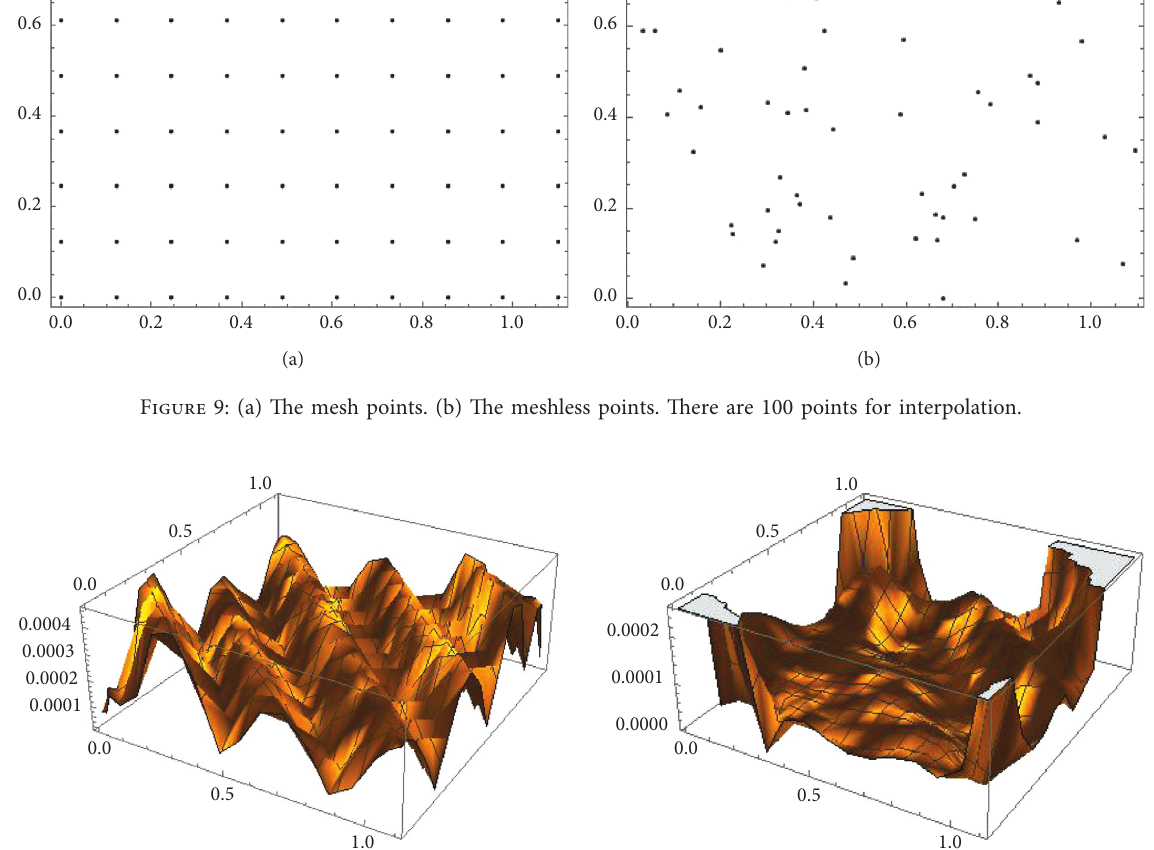
Figure 10: The plot 3D errors for both mesh and meshless points.